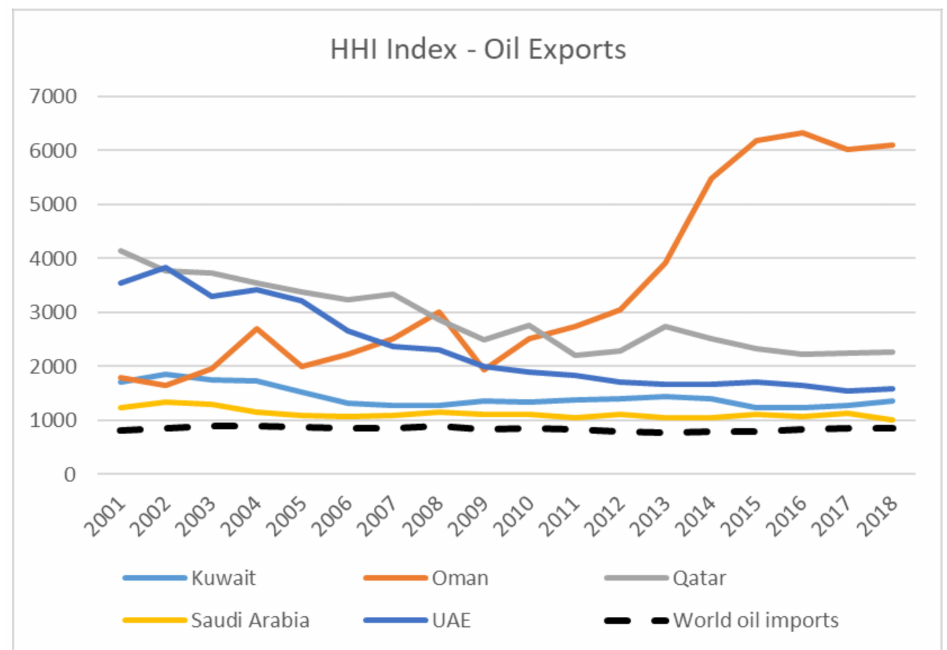
Figure 1. HHI oil export indices for GCC countries. Source: own elaboration on data of